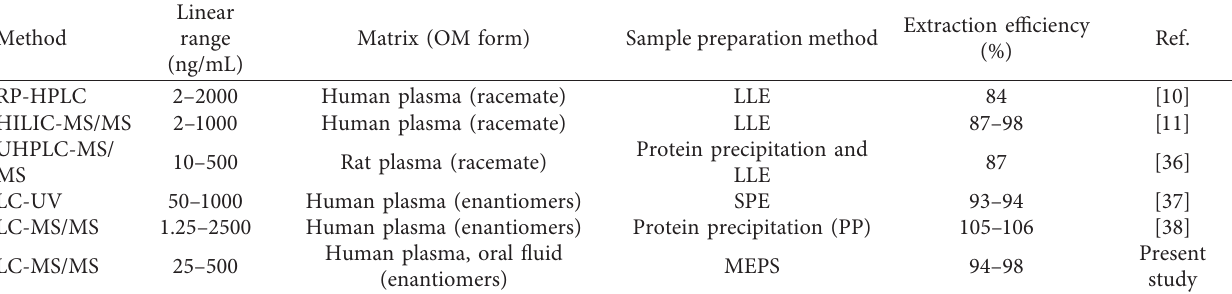
Table 2: Determination of OME with different methods.